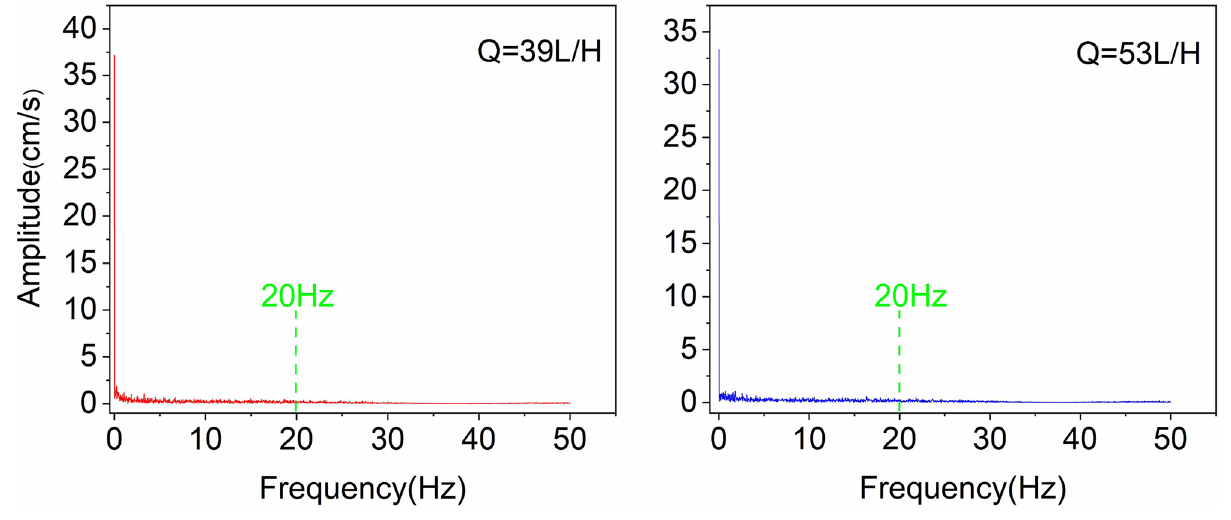
Figure 5. Frequency spectrum of near-bed velocity at different flow